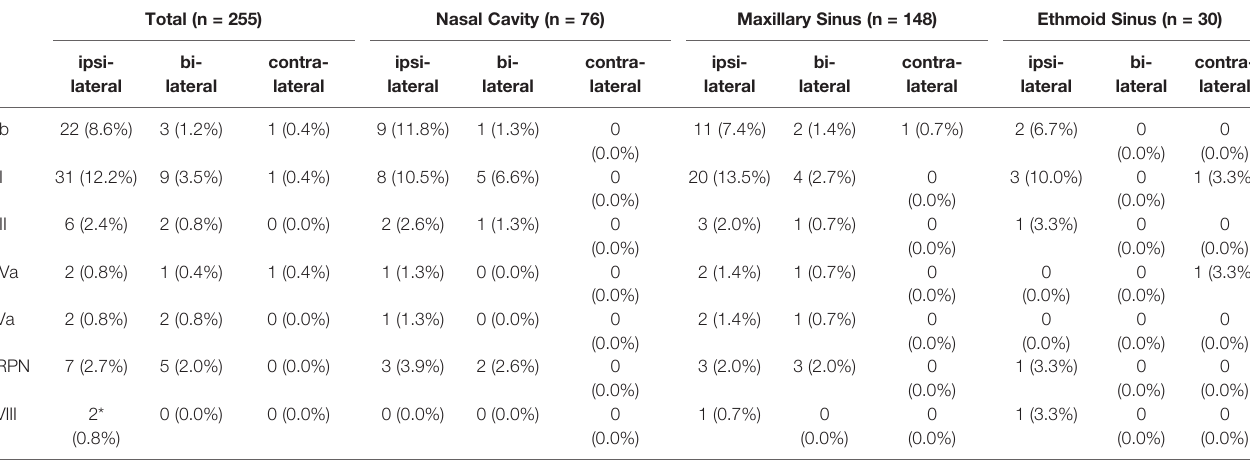
*Both patients had pre-auricular lymph node metastasis.